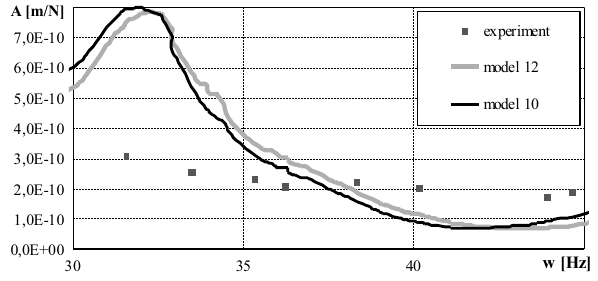
Fig. 16 Dependence of the displacement amplitudes of the forced oscillations of the support No. 4 on the frequencies for models 14 (taking into account the drawdowns) and 15 (taking into account hard contact)